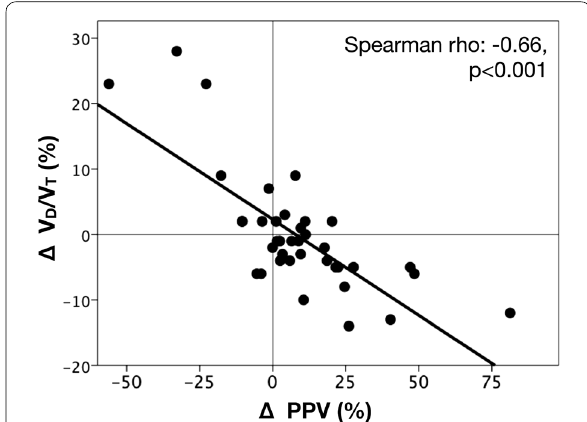
Fig. 3 Relationships between dynamic variations in pulmonary dead‑space fraction ( V D / V T ) and microcirculatory blood flow. Scatter plot depicting the correlation between variations in pulmonary dead‑space fraction (Δ‑ V D / V T ) vs. percentage of change in small vessels perfused (Δ‑PPV) between baseline and 24 h